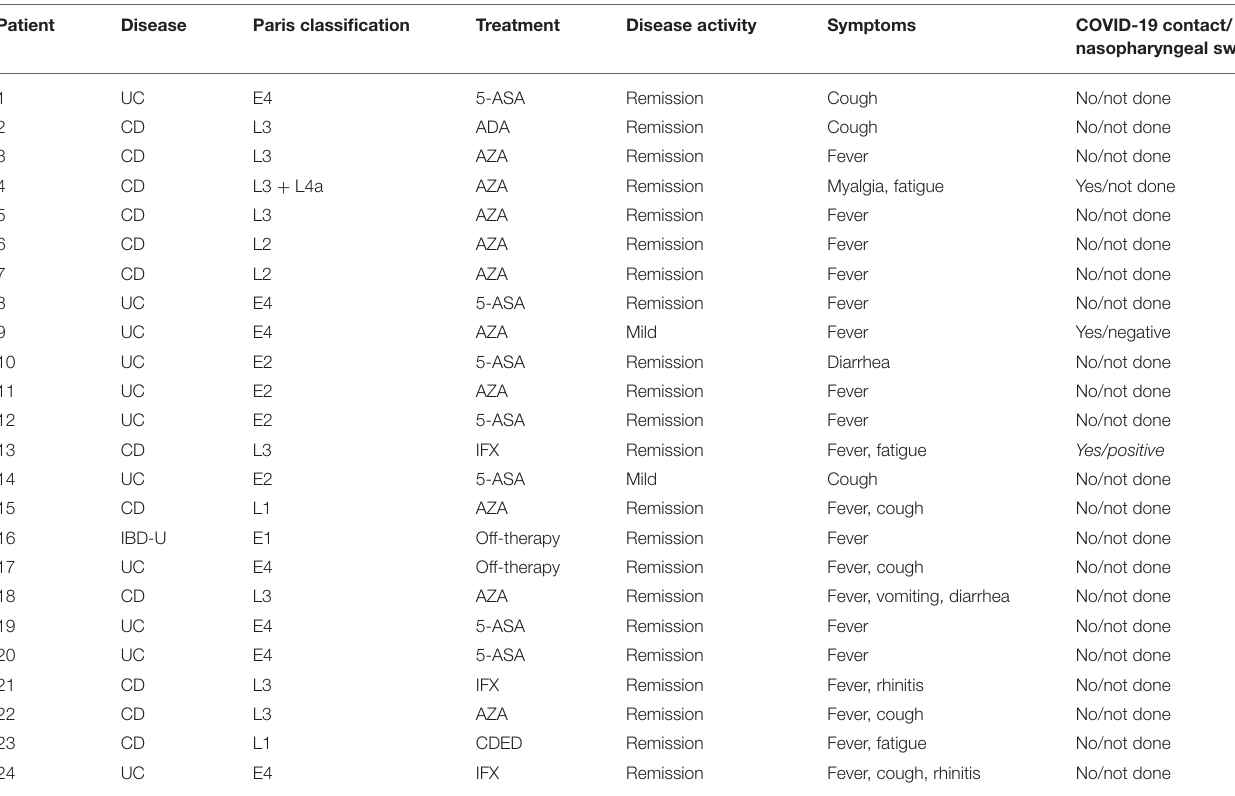
TABLE 2 | Clinical features of likely pediatric inflammatory bowel disease (PIBD) cases presented with suspected severe acute respiratory syndrome coronavirus-2 (SARS-CoV-2) symptoms. Patient Disease Paris